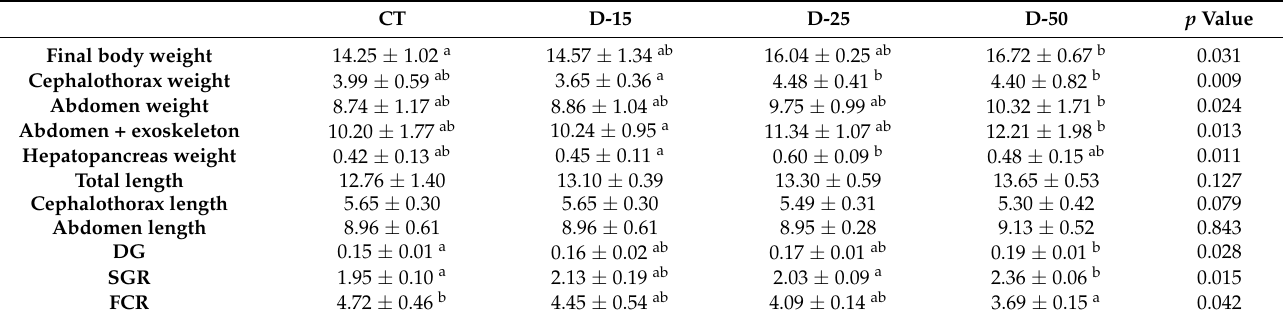
Table 4. Growth performance and nutrient utilization of L. vannamei fed the experimental diets for 70 days. CT